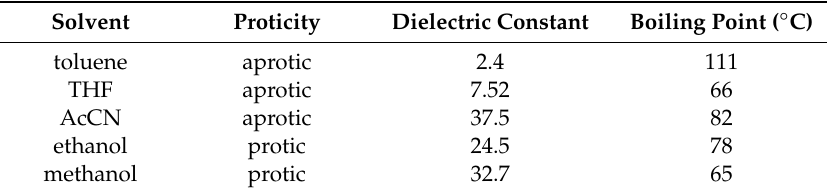
Table 4. Properties of solvents used in BnOH oxidation reactions.